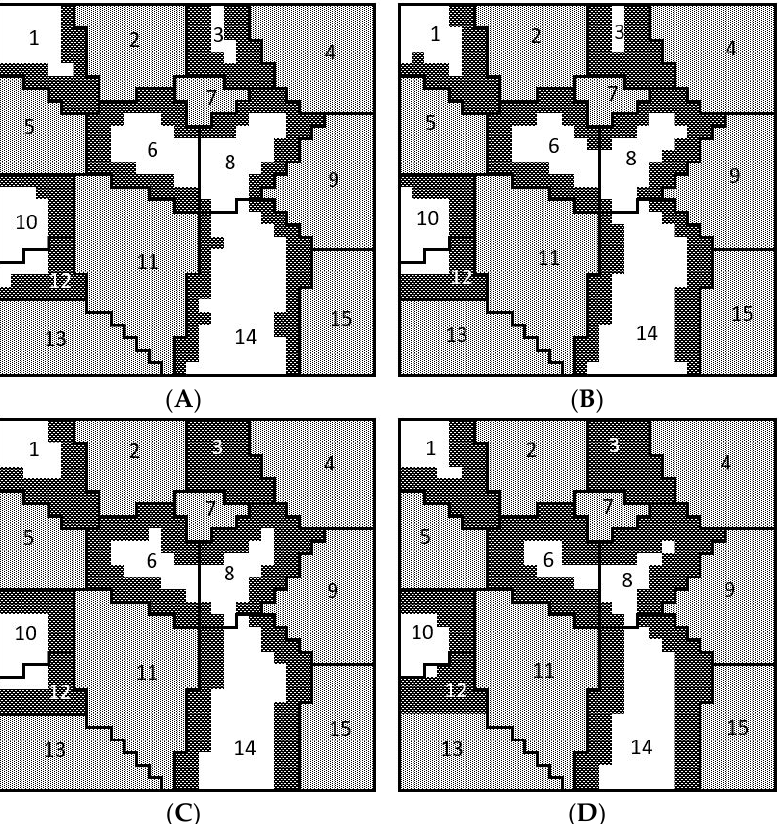
Figure 4. GM, non-GM fields, and buffers. GM producers have the property rights, and buffers are created in the non-GM fields. From top to bottom and from left to right are the 5% ( A ), 1.5% ( B ), 0.9% ( C ), and 0.25% ( D ) thresholds. GM fields are represented with the light grey patterns, buffers are the dark-grey patterned areas, and white areas are the non-GM fields.